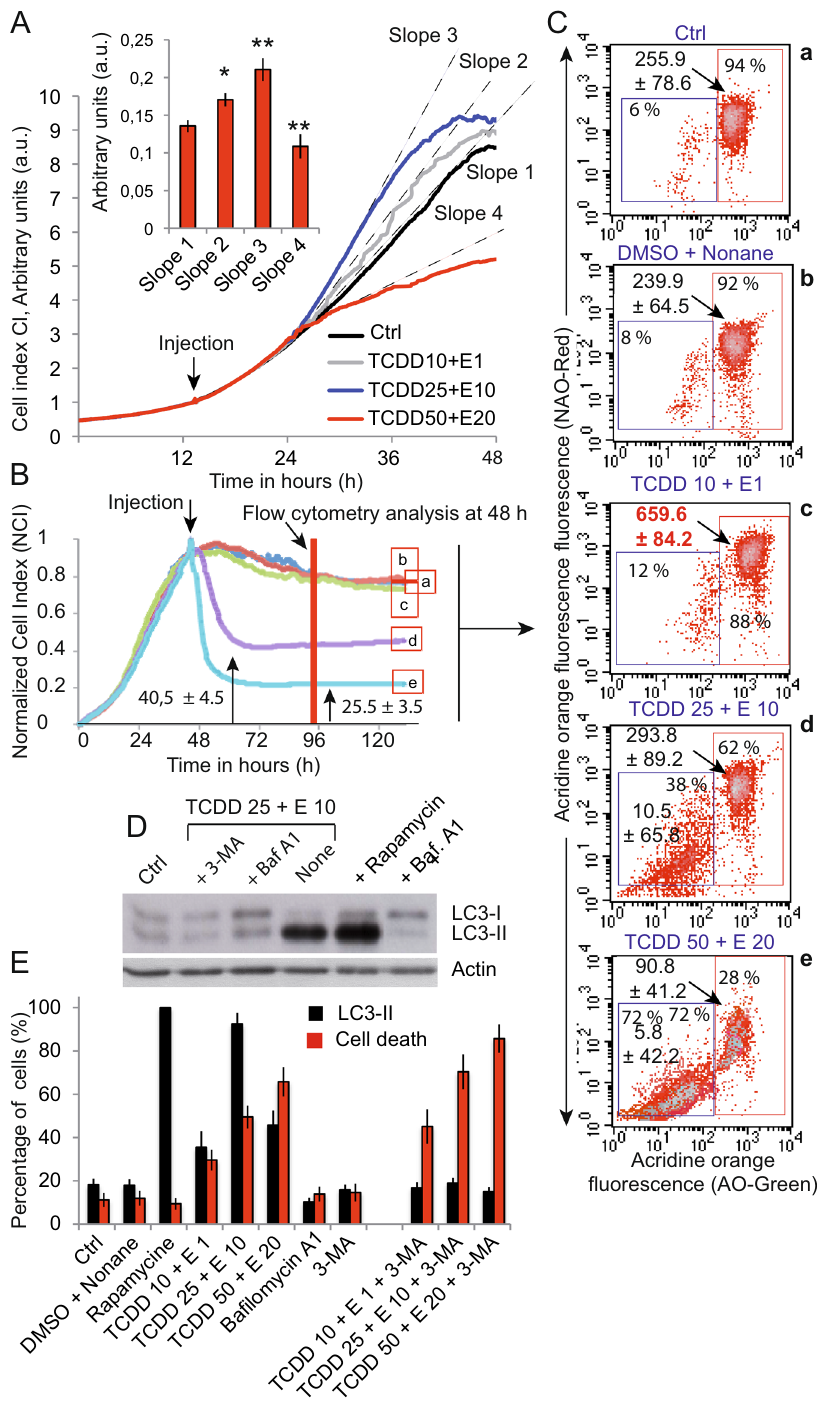
Figure 8. Measurements of Caco-2 cellular proliferation changes upon treatment with different mixtures of TCDD + E (xCELLigence) and of the induction of autophay associated processes. ( A ) xCELLigence measurements of Caco-2 cell proliferation in presence or absence of different mixtures of TCDD + E. Treatments were realized at the early time of the proliferation curve and the slope of the impedance curve is measured as an index of cellular proliferation. An additional histogram resume measurements on a statistical basis (n = 6). ( B ) xCELLigence measurements of Caco-2 cell proliferation realized by exposure to a mixture of pollutants at the late stage of the proliferation curve (80% of the maximum). Cells were untreated (curve a) or treated with DMSO plus nonane (curve b), TCDD 10 + E 1 (curve c), TCDD 25 + E 10 (curve d) or TCDD 50 + E 20 (curve e). Flow cytometric analysis indicates the time at which cells were extracted from XCELLigence device for analysis with indications for different treatments. ( C ) Analysis of the intracellular acidic compartment by acridine orange staining for the cells issued from the xCELLigence device (a to e). Note that the red fluorescence indicates the importance of the acidic compartment within the cell. A decrease